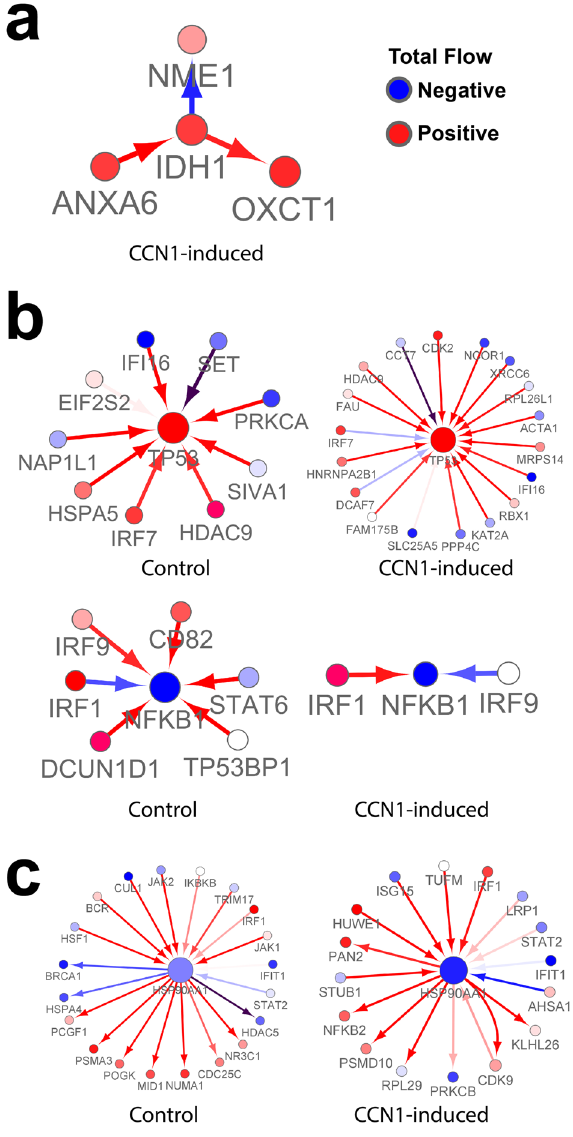
Figure 3. Motif analysis of key genes. ( a ) GBM prognostic marker: IDH1 (only appears in CCN1-induced global network). ( b ) Key Targets: TP53 (increased connectivity in CCN1-induced) and NFKB1 (decreased connectivity in CCN1-induced). ( c ) High impact genes: HSP90AA1. Some rewiring is observed in this autophagy